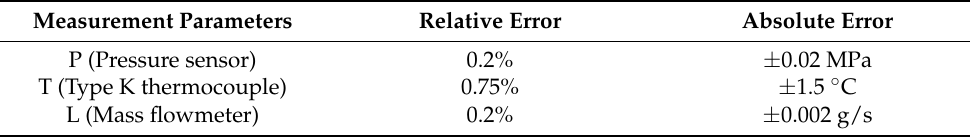
Table 2. Uncertainty of direct measurement of test